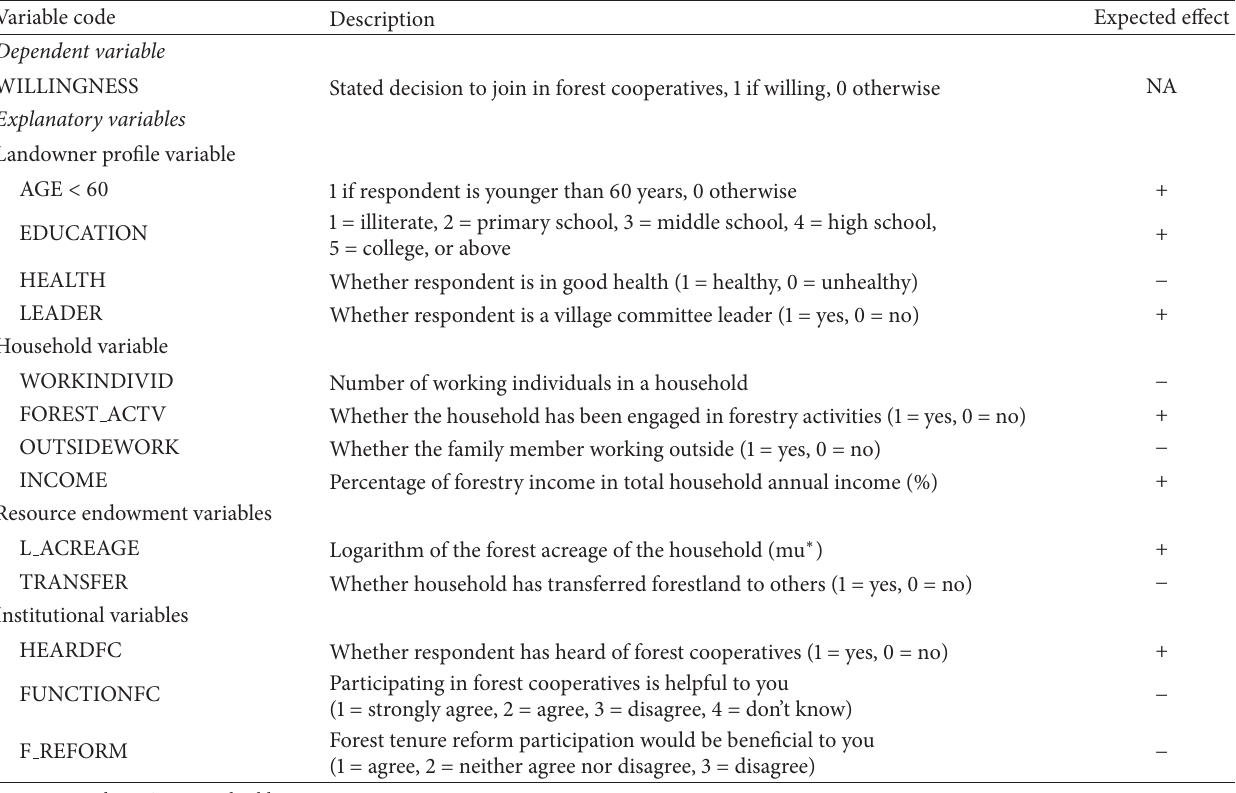
Table 2: Description of dependent variable and explanatory variables used in the logistic regression model.